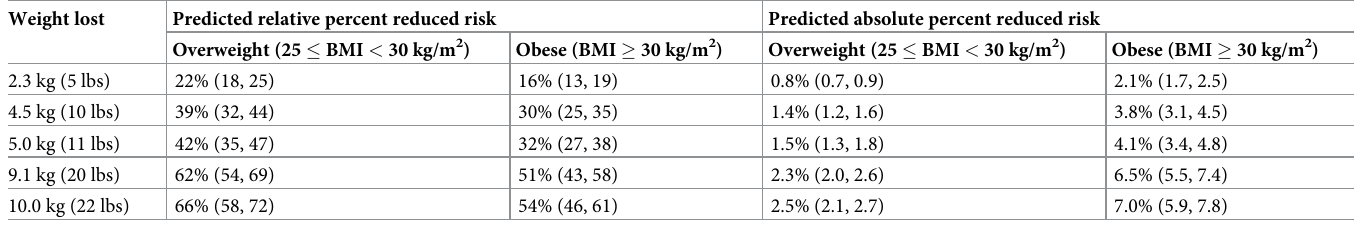
Table 4. Predicted relative and absolute diabetes risk reduction resulting from various amounts of weight loss, for a 1.7-meter-tall individual. Weight